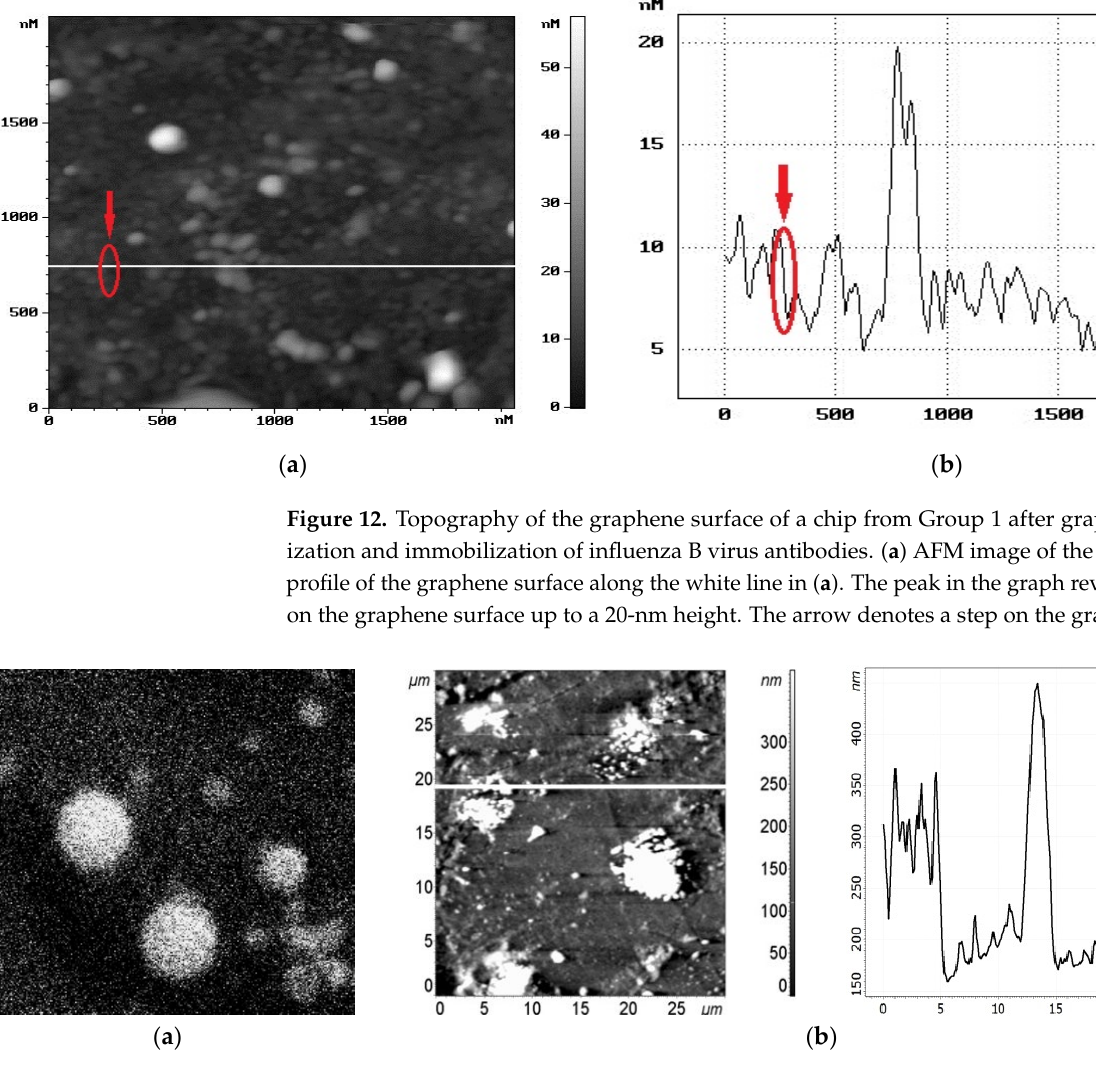
Biosensors 2022 , 12 , 8